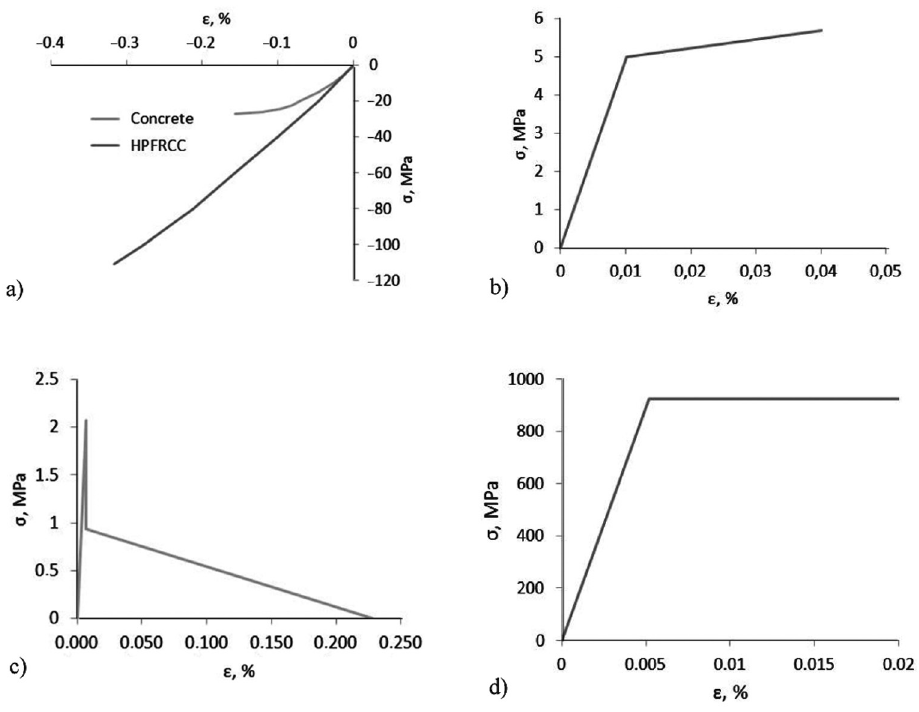
Fig. 8. Stress-strain curves evaluated in the finite element model: (a) compressed concrete and HPFRCC, (b) tensioned HPFRCC, (c) tensioned concrete, (d)